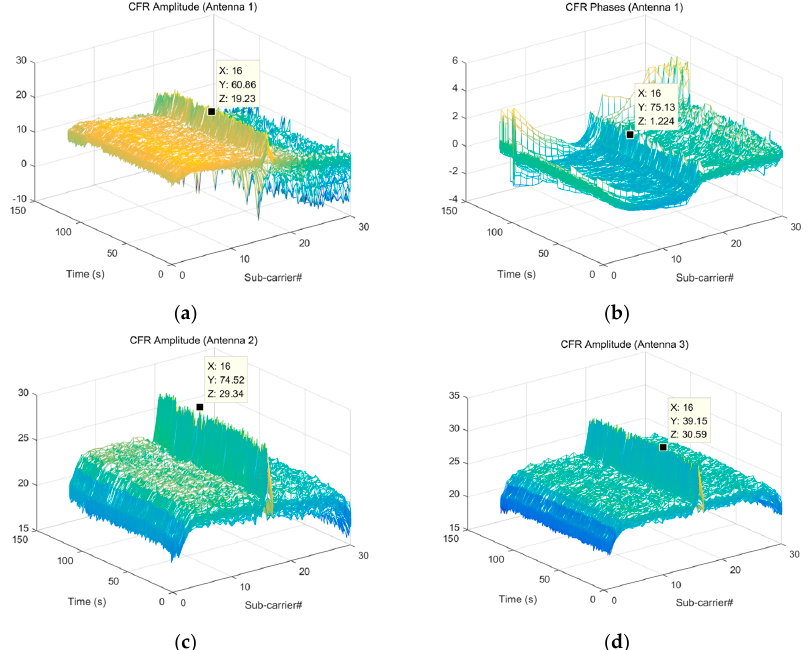
Figure 3. ( a ) The CFR (channel frequency response) amplitude from antenna 1. ( b ) The CFR phase from antenna 1. The CFR amplitude from ( c ) antenna 2 and ( d ) antenna 3.